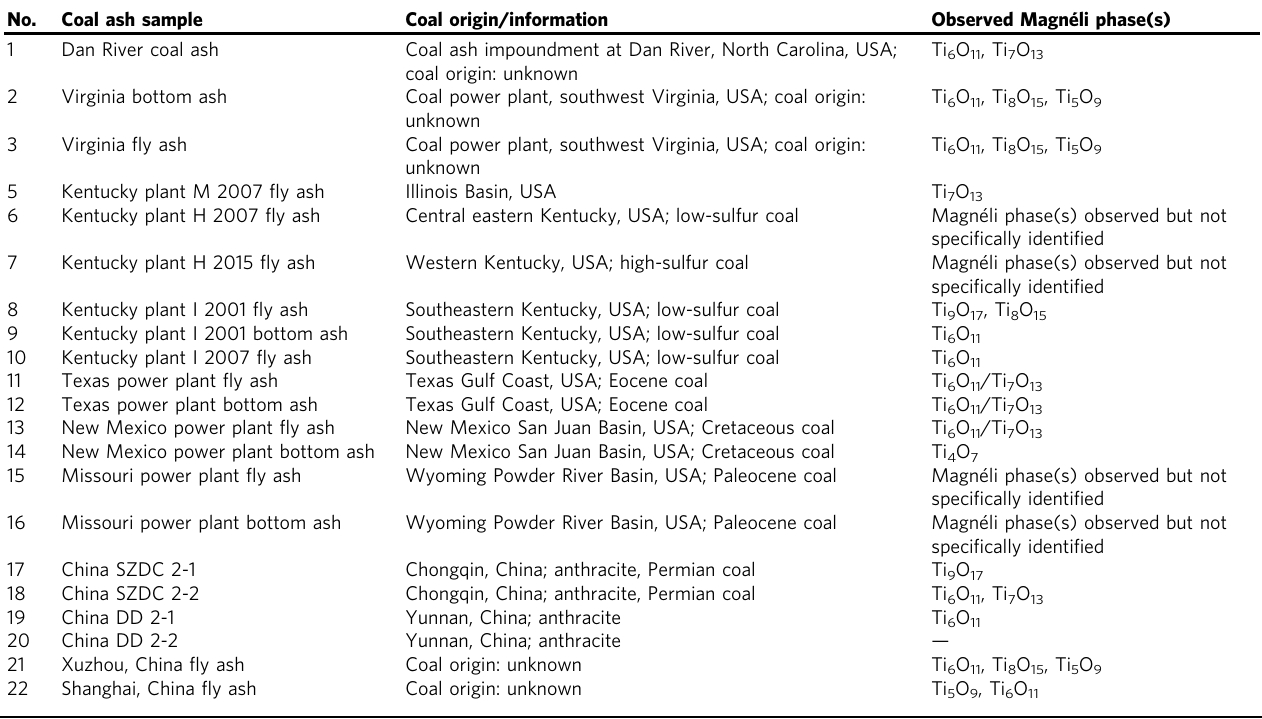
Table 1 Coal ash samples tested for occurrence of Magnéli phases using TEM